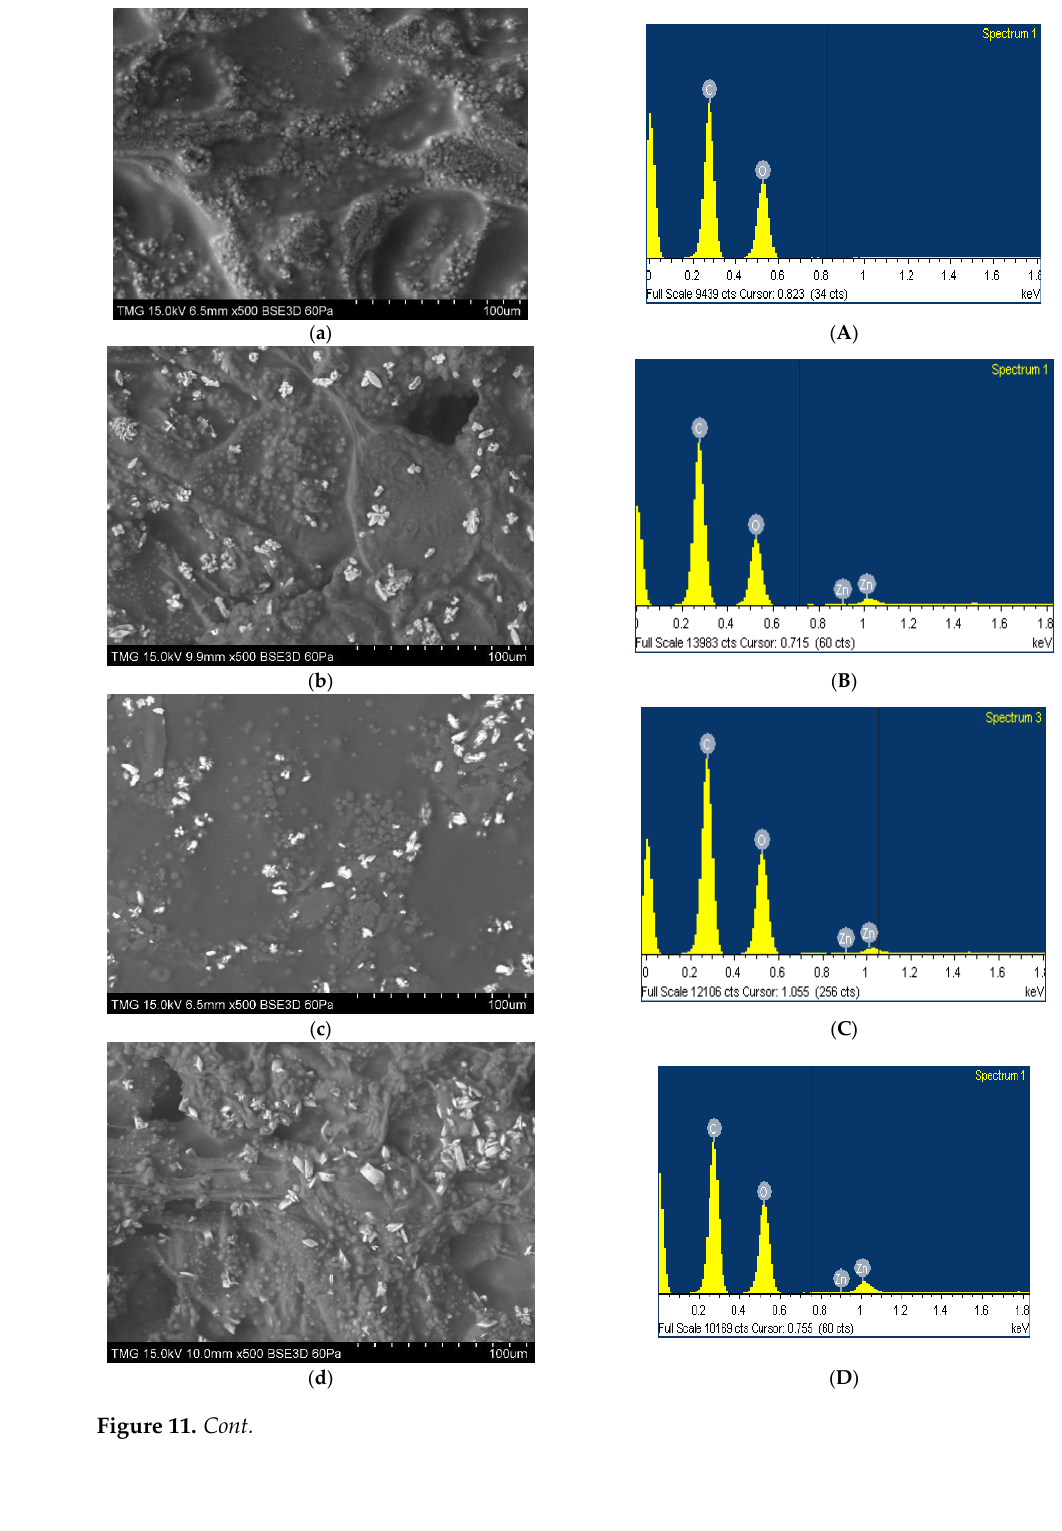
(Figure 11e, the glass-side surface of the material), might be agglomerated during bioplastic formation because these spots were not found in bioplastics without nZnO.